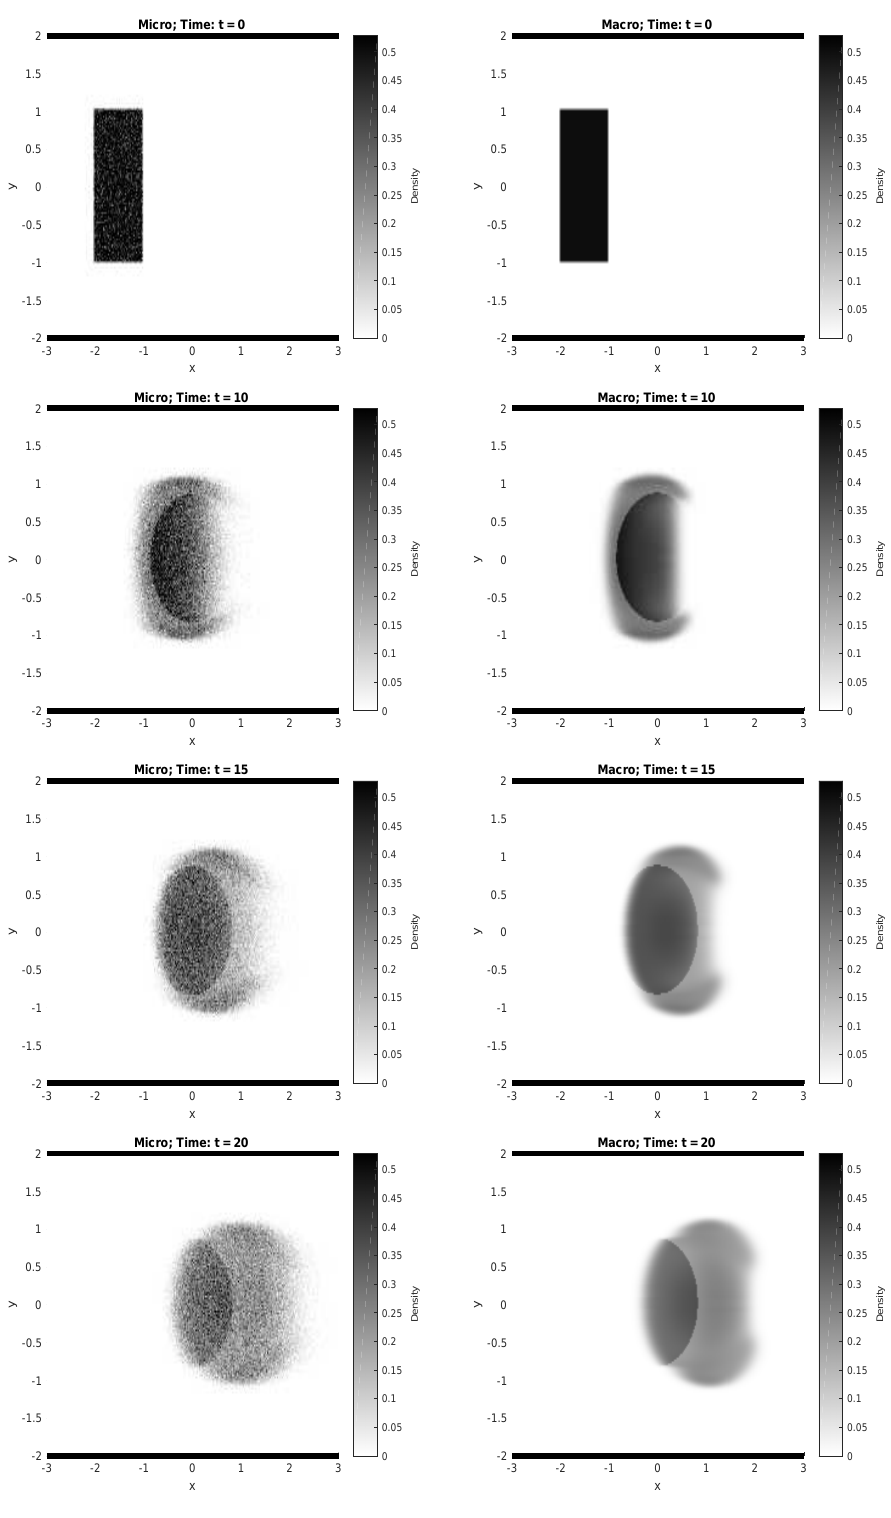
Figure 4: Densities at different